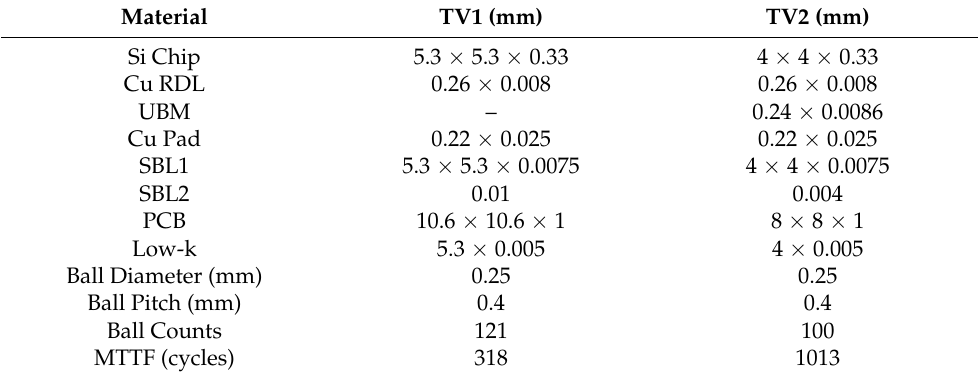
Table 1. Dimension of WLP TV1 and TV2.